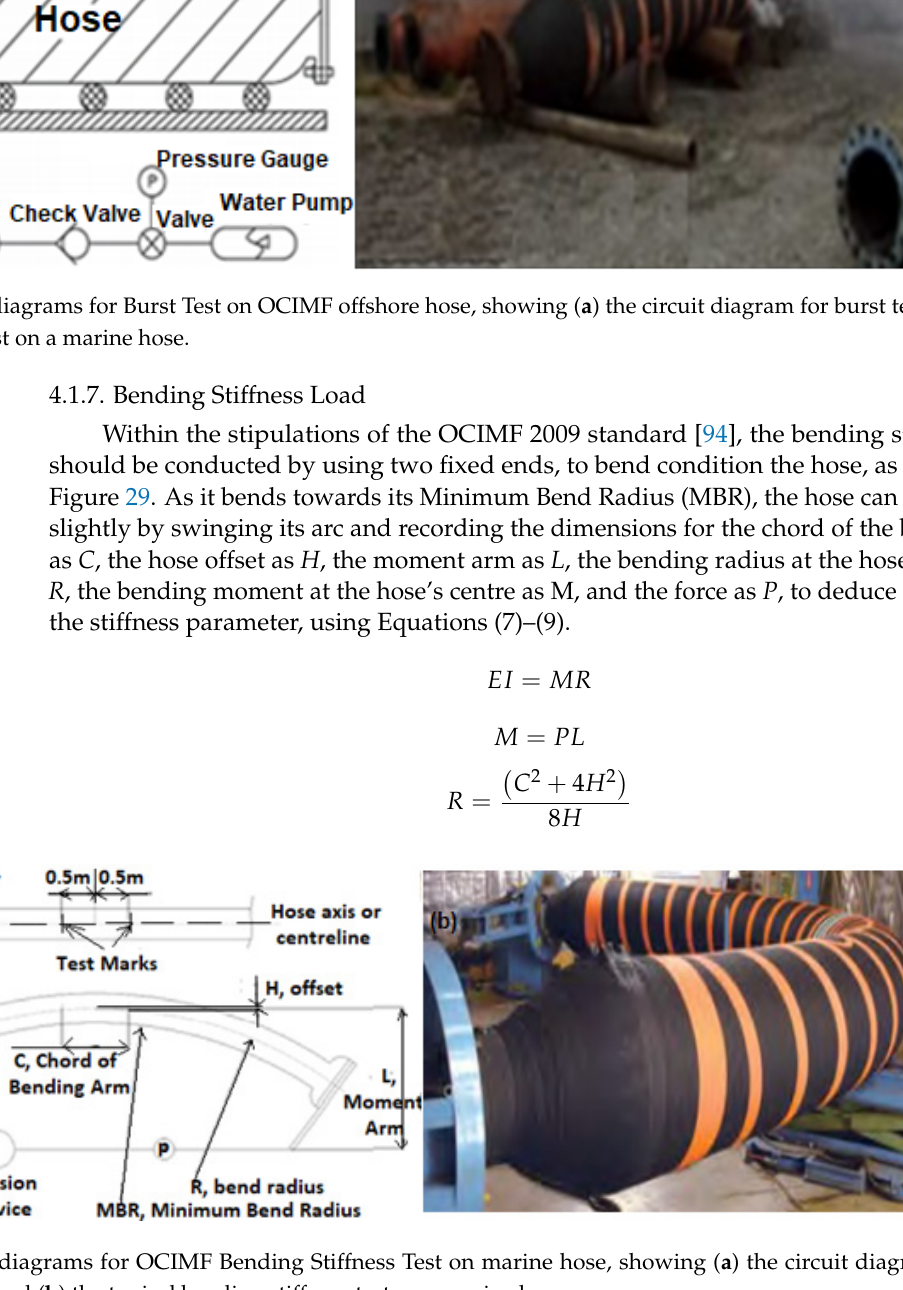
Figure 27. Depiction of crush load test on hose.